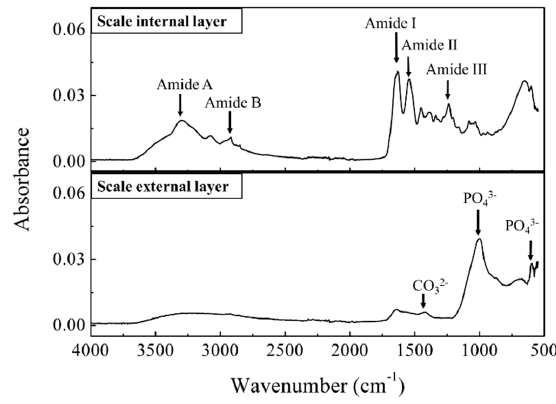
Figure 4. Fourier Transform Infrared (FTIR) spectra of the red sea bream scale: the upper part is the internal layer, and the lower part is the external layer of the scale.